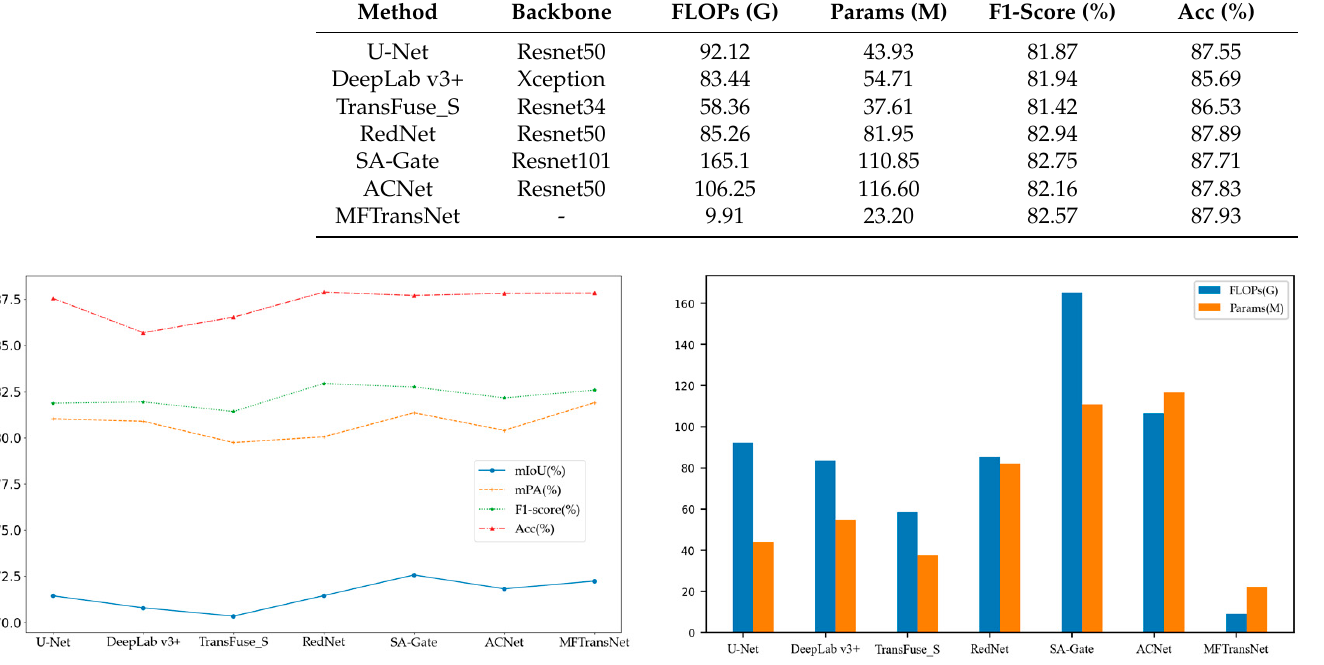
Figure 10. Comparison chart of model size and accuracy (On the left is a line graph of each indicator representing accuracy, and on the right is a bar graph of each indicator representing size).